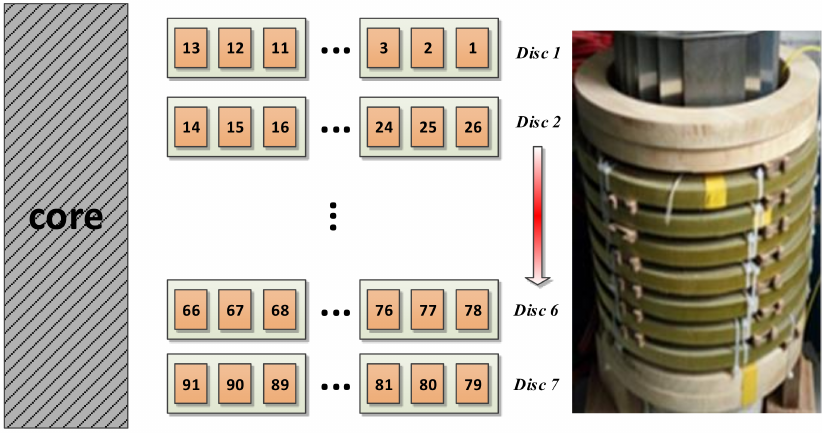
Figure 1. The structure of the single-winding experiment